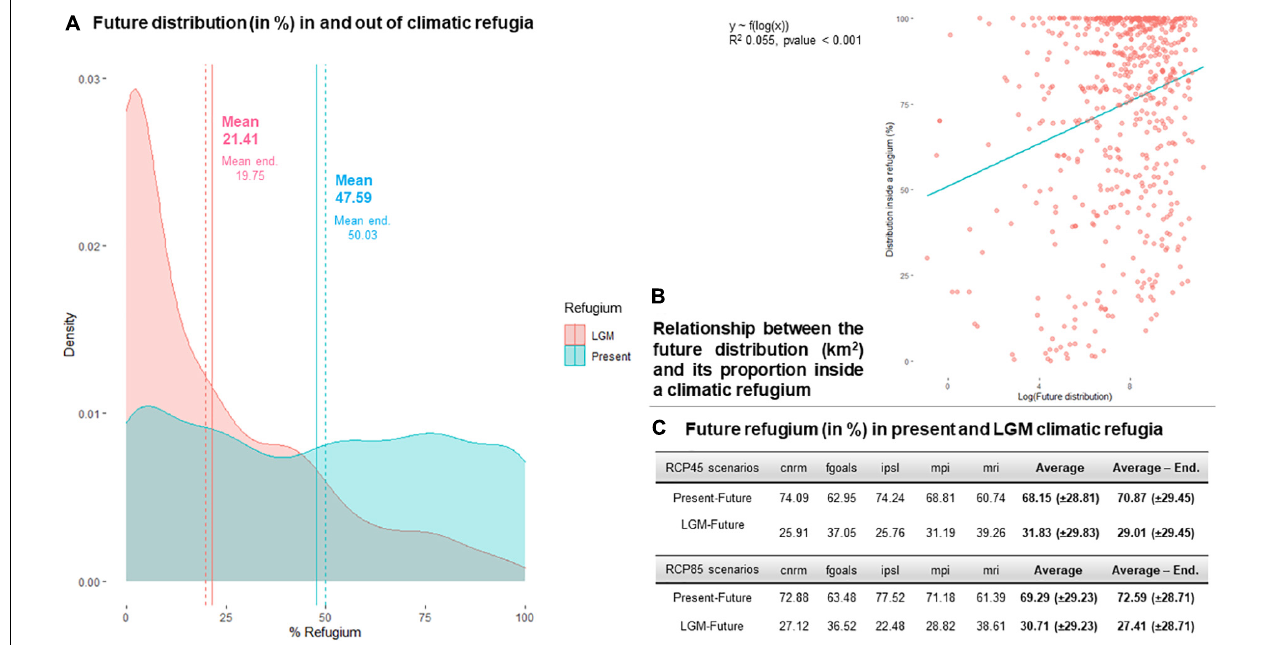
FIGURE 5 | Relationships between the future distribution of the 664 studied species at 2070 and their climatic refugia since the present time (2010, PF) and since the LGM (PPF). (A) Proportion of future distributions in a LGM refugium and in a present refugium, for the complete species pool and for endemics only. (B) Relationship between the area occupied by species’ future distributions and their refugium size (PF and PPF, for individual responses see Supplementary Figure 1 ). (C) Distribution of the species refugium between PF and PPF.